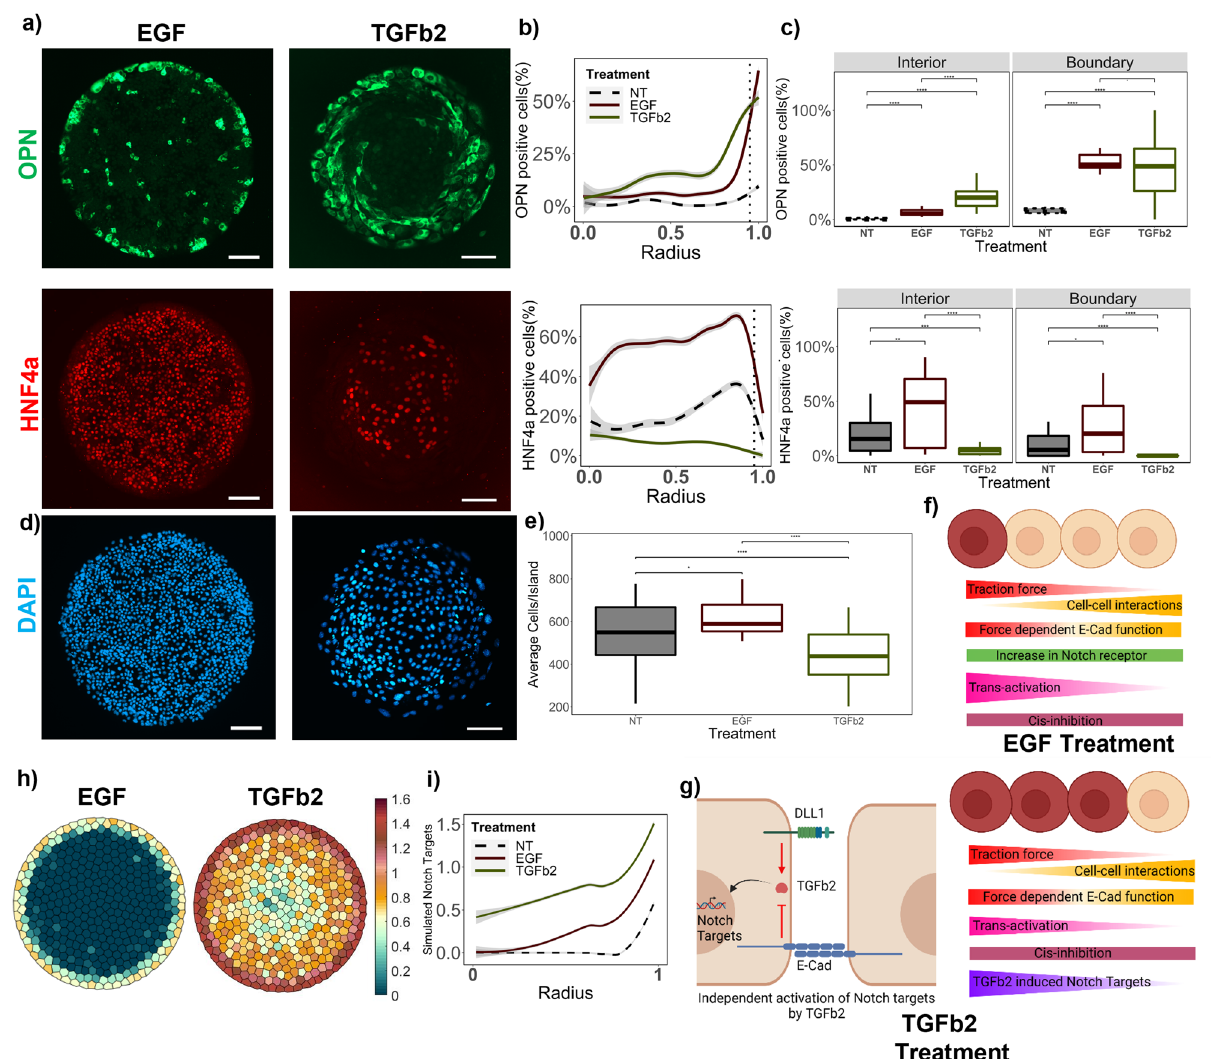
Fig. 5 Effect of extrinsic growth factor treatments on patterned differentiation. a Representative fl uorescent Images of EGF and TGF β 2 treated wild-type BMELs on Col 1 microarrays on 25 kPa polyacrylamide hydrogels. Red: HNF4a, Green: OPN, Blue: DAPI. Scale Bar: 100 μ m. b Quanti fi cation of average percent HNF4a + and OPN + cells/island as a function of the radius. 0 is center, 1 is the edge, vertical dashed line at radius = 0.95. c Quanti fi cation of average percent HNF4a + and OPN + cells/island in the interior (radius = 0 – 0.95) and at the boundary (radius = 0.95 – 1.00). d DAPI fl uorescent Images for EGF and TGF β 2 treated wild-type BMELs on circular microarrays. Scale Bar: 100 μ m. e Quanti fi cation of Average Cell Number per individual island for EGF and TGF β 2 treated wild-type BMELs. f , g Schematic of the simulated in silico growth factor treatments in the base model. Made using biorender.com. h Simulated Notch target genes on cells on a circular lattice, with in silico growth factor treatments. Heatmap color: arbitrary unit for Notch target genes. i Quanti fi cation of simulated Notch target genes in cells on a circular lattice for the in silico growth factor treatments. Line plots — Gray: 95% con fi dence interval. Boxplots —‘ . ’ : ns; * p -value < 0.05; ** p -value < 0.01; *** p -value < 0.001 **** p -value < 0.0001, calculated using Wilcox test in R. n ≥ 4